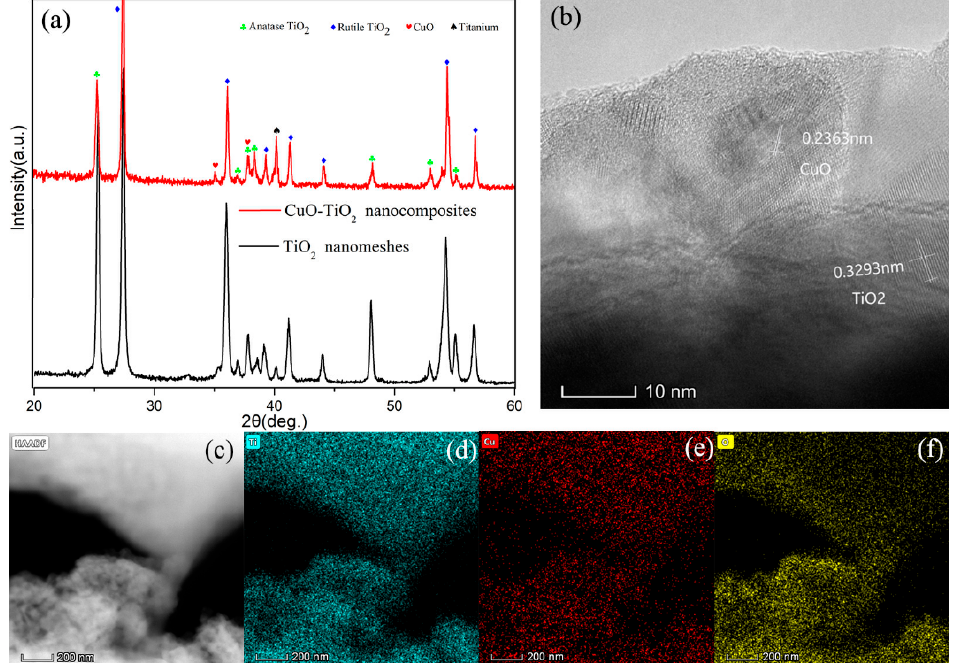
Figure 2. ( a ) X-ray diffraction pattern of CuO-TiO 2 nanocomposites and pure TiO 2 nanomeshes; ( b ) HRTEM image of CuO-TiO 2 nanocomposites; ( c – f ) TEM image and corresponding element maps of CuO-TiO 2 nanocomposites.